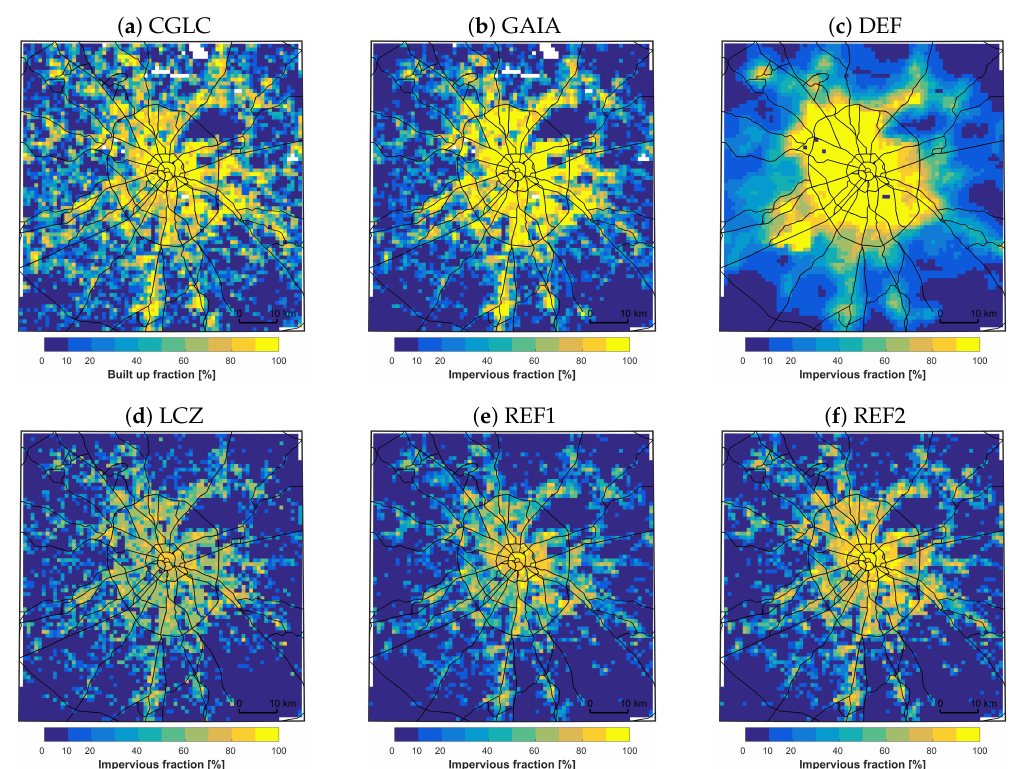
Figure 4. Comparison between built up area fraction according to Copernicus Global Land Cover (CGLC) dataset ( a ), the impervious area fraction according to Global Artificial Impervious Area (GAIA) dataset ( b ), derived as default dataset from EXTPAR ( c ), defined according to Local Climate Zones (LCZ) ( d ), REF1 ( e ) and REF2 ( f ) approaches. All datasets represent the mean values over 1 km 2 grid cells.